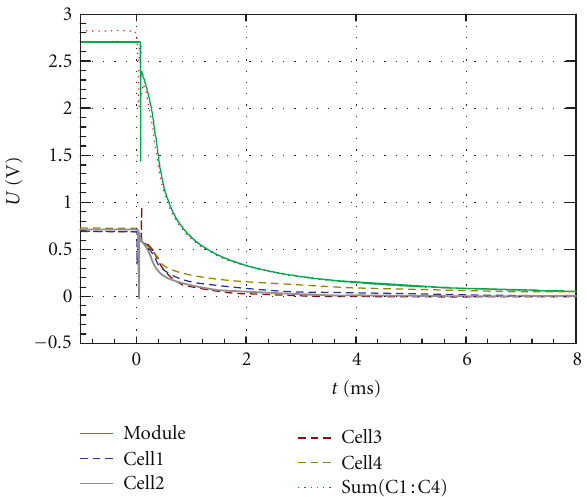
Figure 8: OCVD signal of the 4-cell mc-Si module and its individual